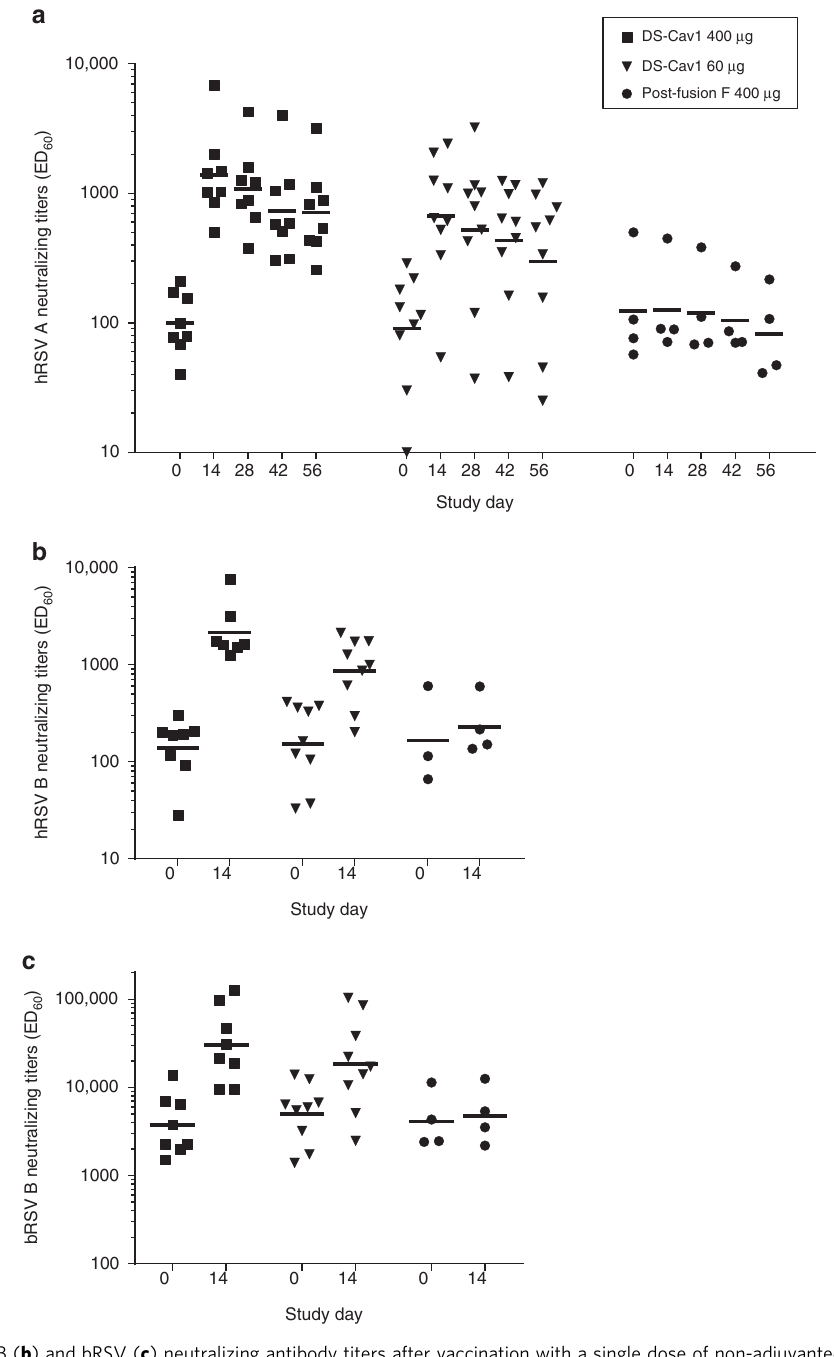
Fig. 3 hRSV A ( a ), hRSV B ( b ) and bRSV ( c ) neutralizing antibody titers after vaccination with a single dose of non-adjuvanted proteins. Horizontal bars indicate the geometric mean titer (GMT) at each time point. One animal in the high dose DS-Cav1 group did not respond to the vaccine and was excluded from the